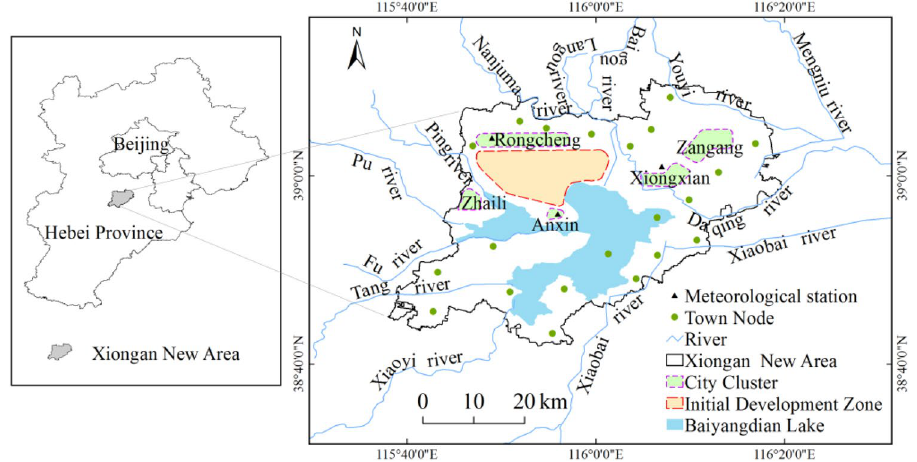
Figure 1. Location of Xiongan New Area and its urban–rural space layout. The map was generated using ArcGIS 10.1. Source: Map of Xiongan New Area comes from the master plan for Xiongan New